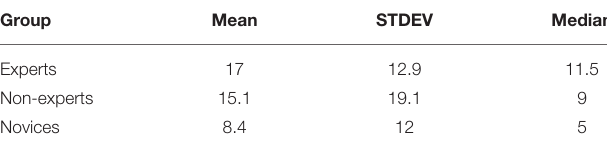
TABLE 1 | The means and standard deviations for creep score for each group.